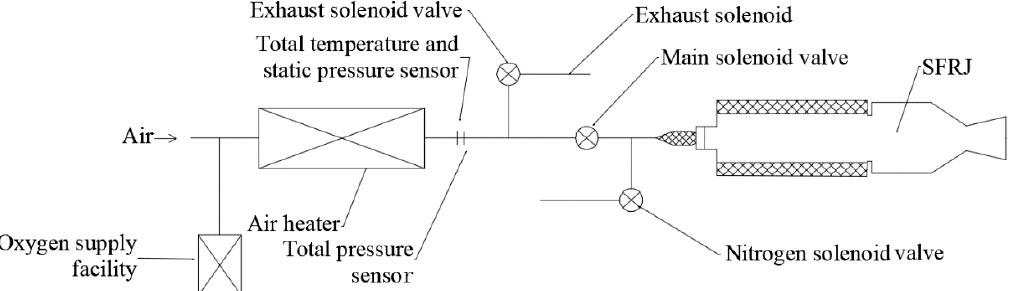
Figure 1. Schematic of connected pipe test facility.